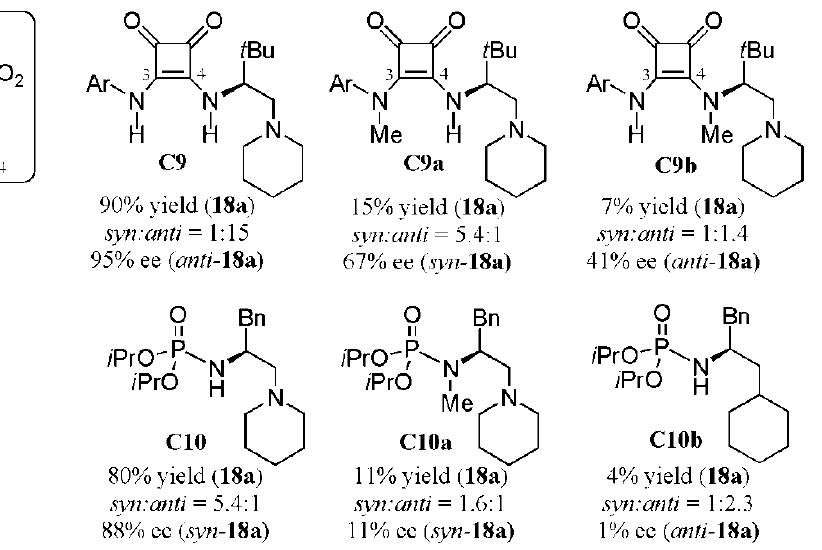
Figure 13. Stereodivergent synthesis of 18a [37].